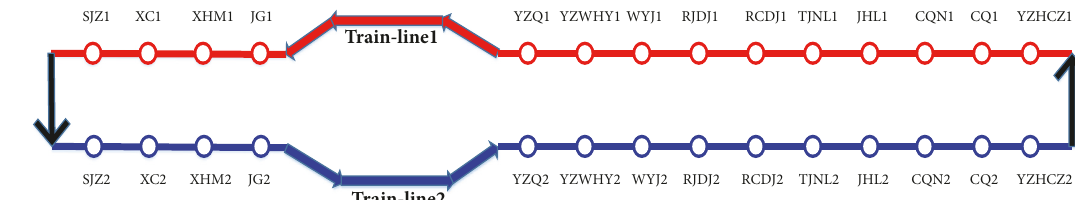
Figure 5: Railway network considered for numerical experiment.